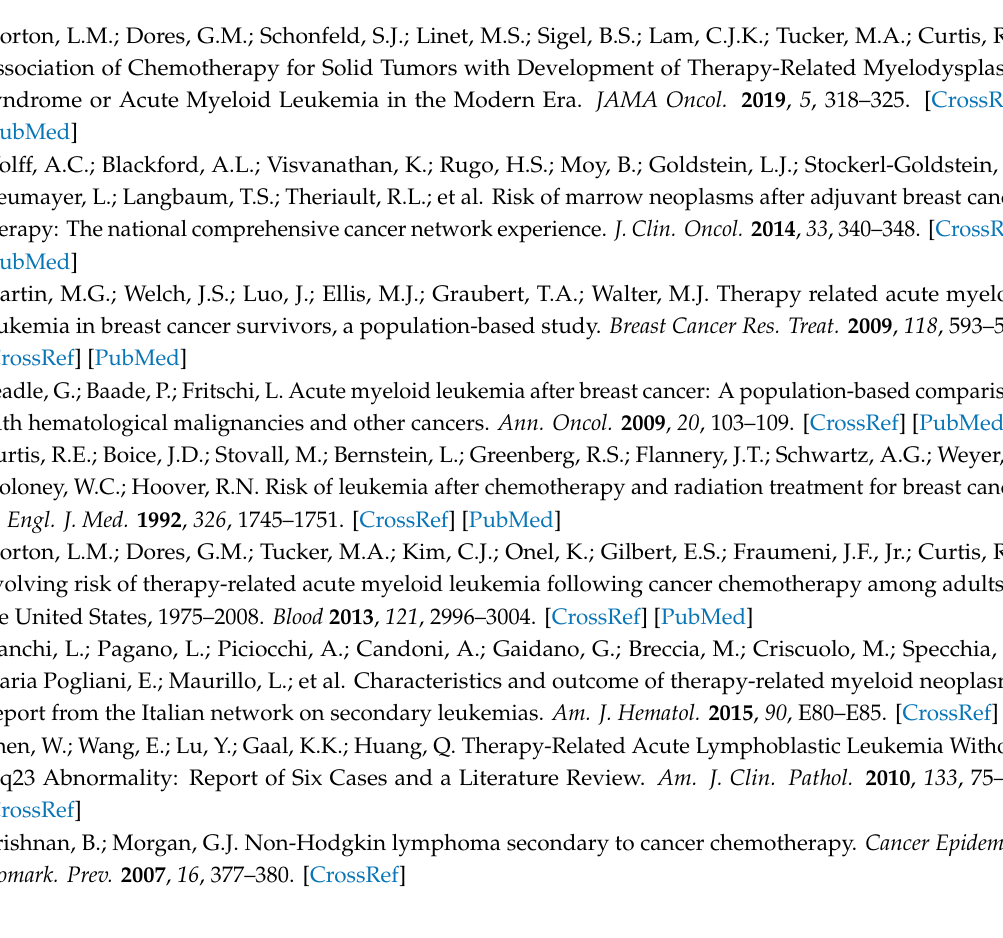
Figure S1: Cumulative Incidence function of hematologic malignancies by Exposure groups, Figure S2: Survival curves after hematologic malignancies, Table S1: Detailed definition of the exposure with the corresponding codes, Table S2: Detailed definition of the covariates with the corresponding codes, Table S3: Detailed definition of the outcome subtypes with their ICD-10 codes, Table S4: Associations between exposure groups, covariates, and the risk of hematologic malignancies in the full Cox Multivariable model, Table S5: Incidence and Risk of hematologic malignancies (HRs) in patients exposed to hormone therapy, Table S6: Fine and Gray analyses: Sensitivity